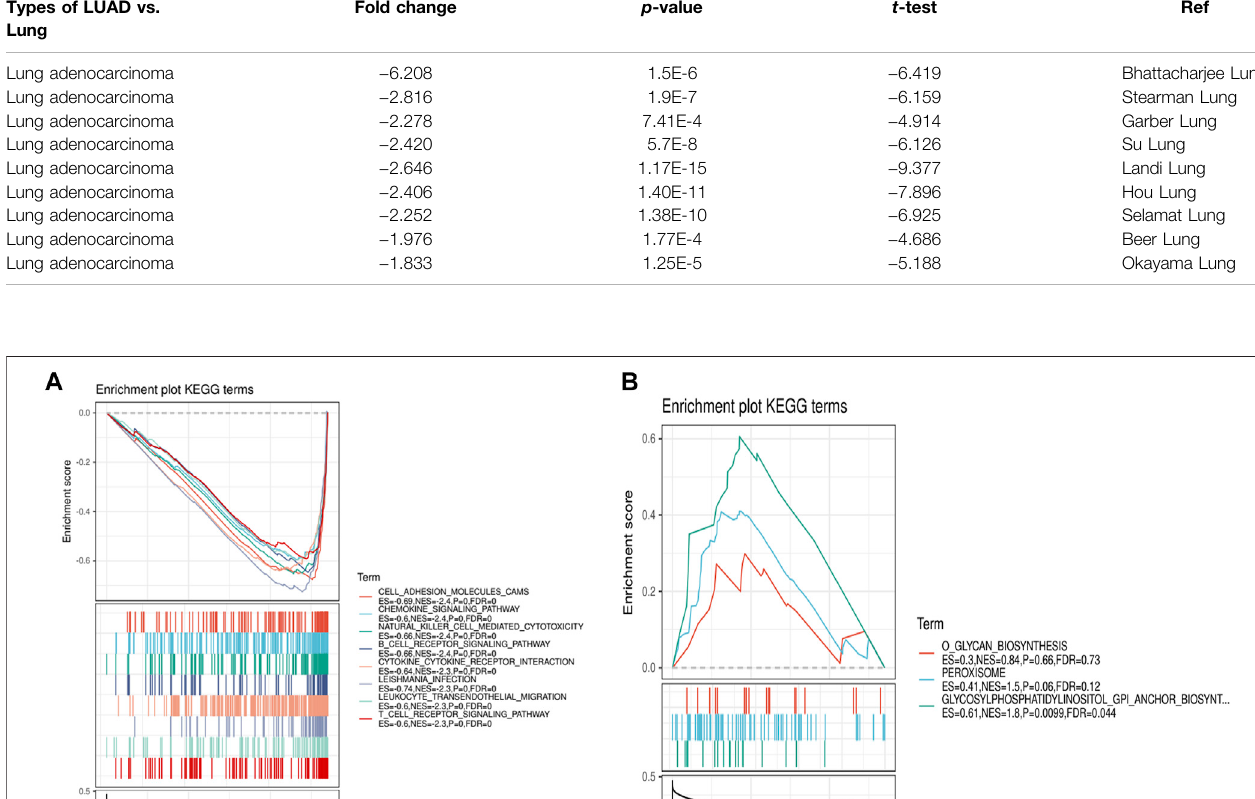
TABLE 1 | Transcription expression of IL7R between LUAD and normal lung tissues (Oncomine). Types of LUAD vs. Lung